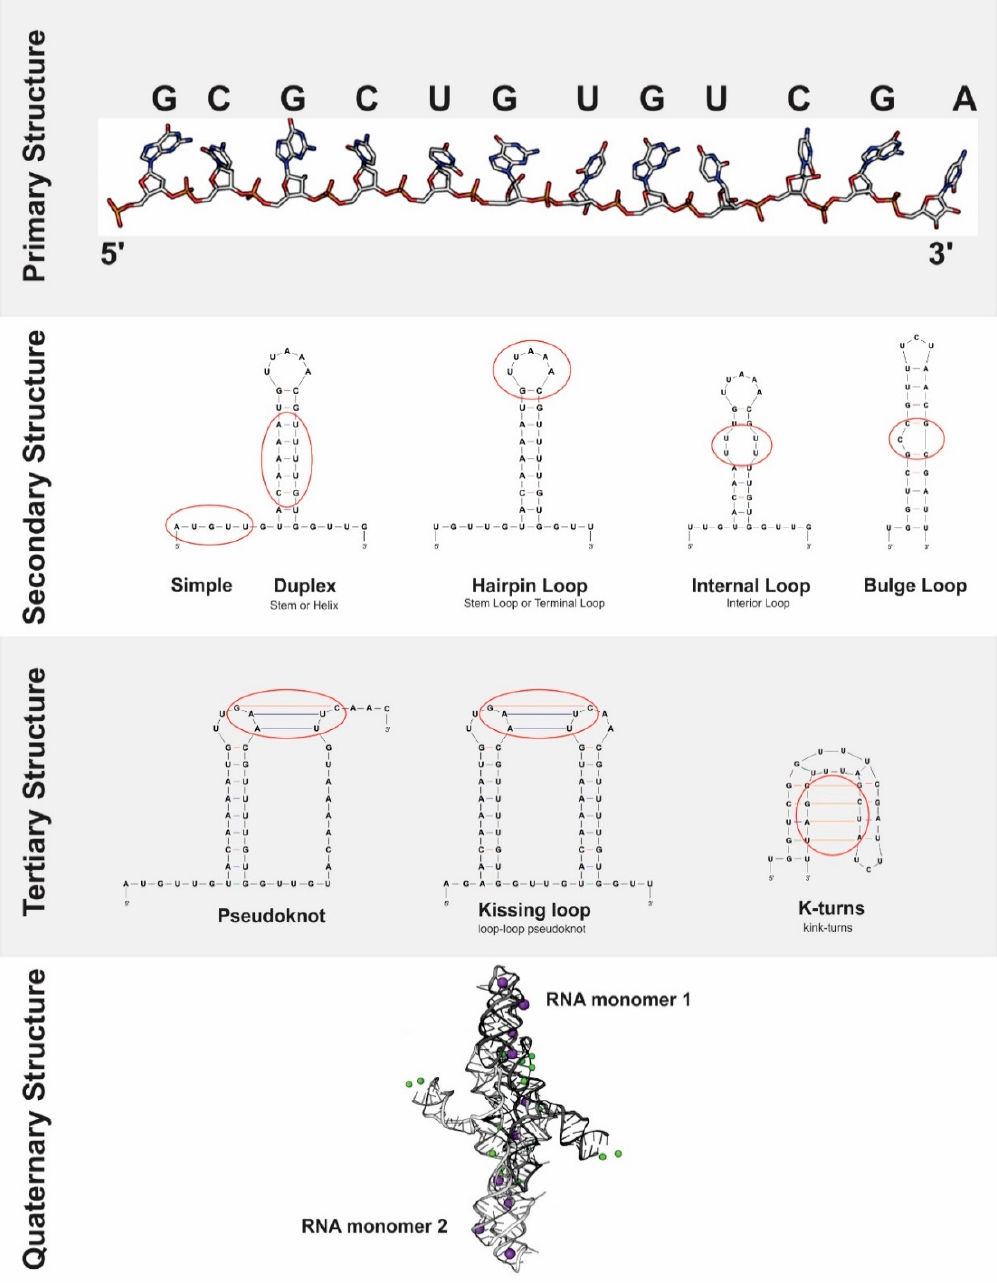
Figure 3. RNA Structures. RNA is a very important molecule for many processes within the cell and its activity is largely determined by its structure (the way it is folded on itself). Although in most cases RNA is a single-stranded molecule, the most stable conformation of a nucleic acid is double-stranded, which is why RNA molecules tend to adopt secondary and tertiary structures by means of intramolecular interactions among the ribonucleotide bases of primary sequence, and even quaternary structures. The illustrated examples are the common structures that RNA molecules adopt in cells.